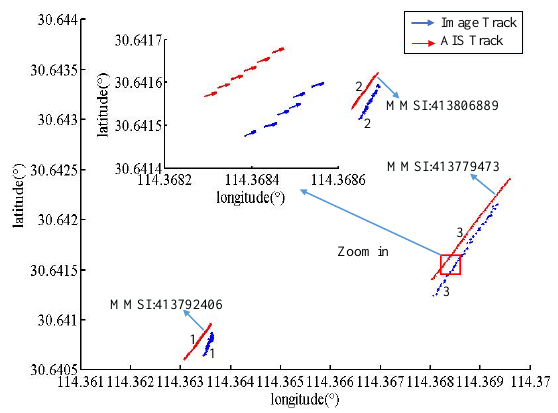
Figure 15. The identification results for two vessels.